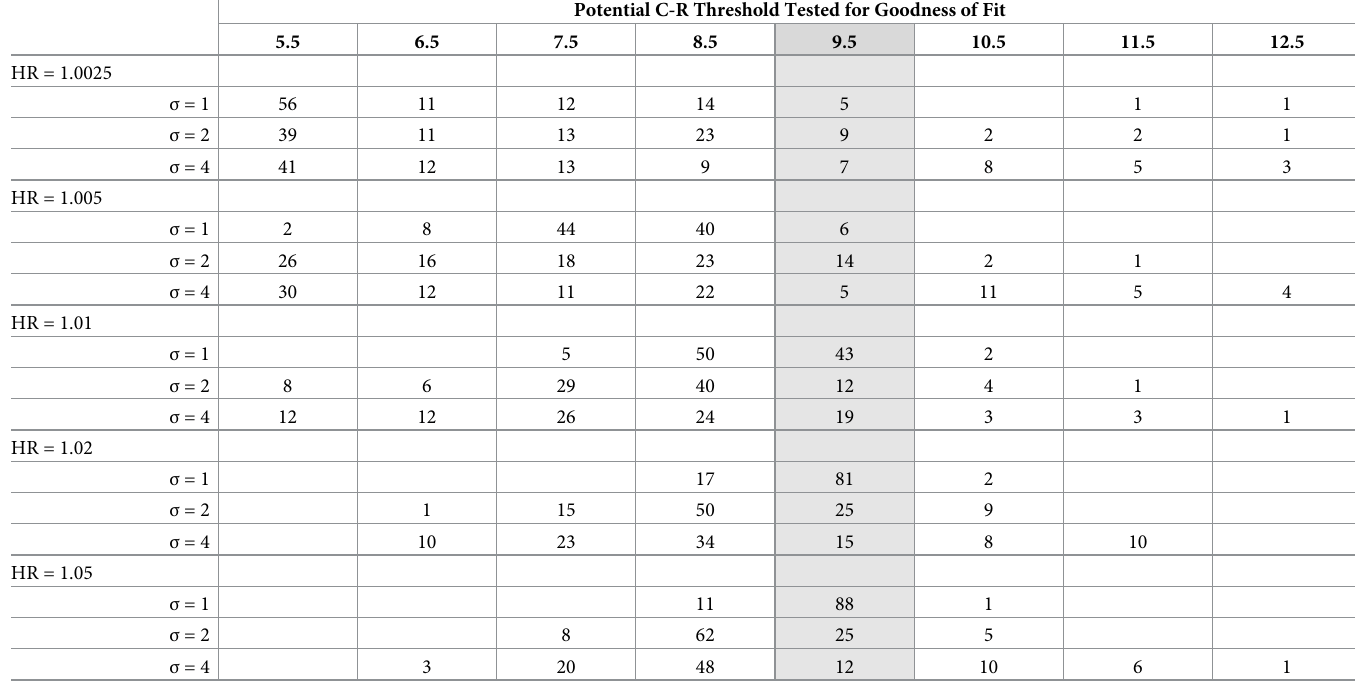
Table 4. Best-fitting C-R threshold level under varying amounts of measurement error, true threshold =